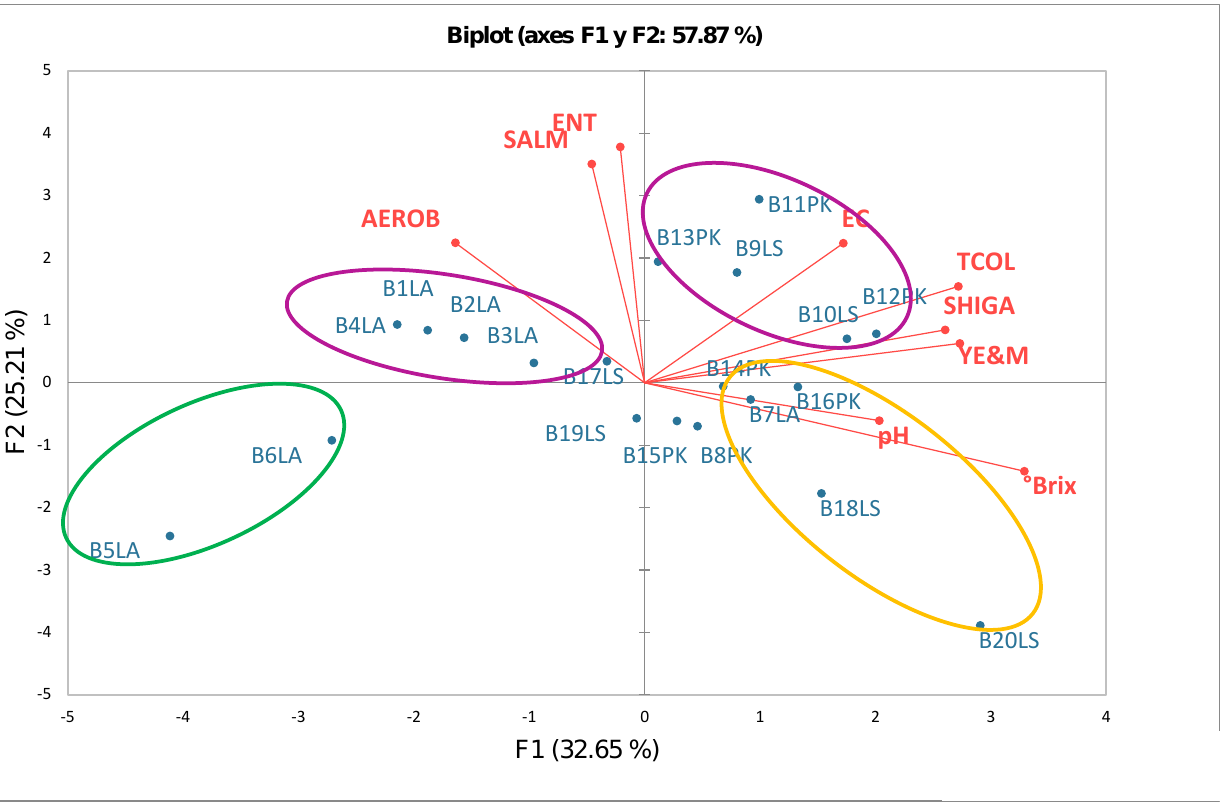
Figure 2. Biplot PCA analysis of 9 variables (pH, °Brix, TCOL, EC, AEROB, SALM, SHIGA, ENT, YE, M) of juices (20) purchased from the food courts. Legend: TCOL: total coliforms; EC: E. coli ., AEROB: total aerobes; SALM: Salmonella spp., SHIGA: Shigella spp., ENT: Enterobacter spp., YE&M: Yeasts/Molds. LA: low-cost market Amazonas; PK: park Centrica; LS: low-cost market Santo Domingo. The color circles marked the close related samples. Red color: active variables; Blue color: active observations.